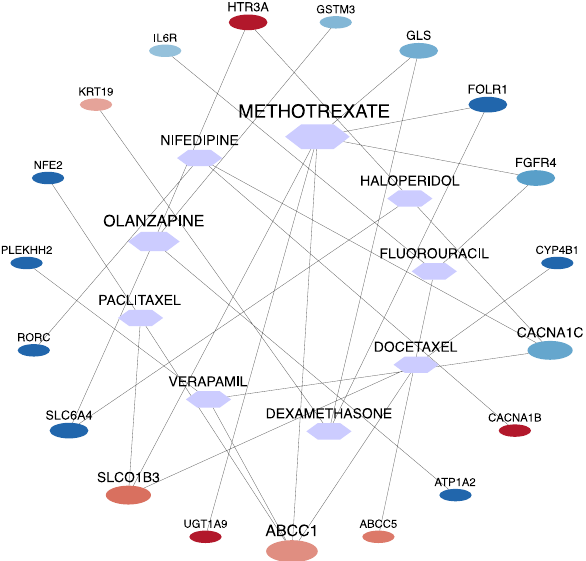
Figure 5. The expression level of hub drugs’ target genes in the NSCLC group compared to the normal group. The circle and hexagon shapes represent genes and drugs, respectively. The size of a node indicates its degree (this figure was drawn in the Cytoscape 43 v.3.8.2 software).